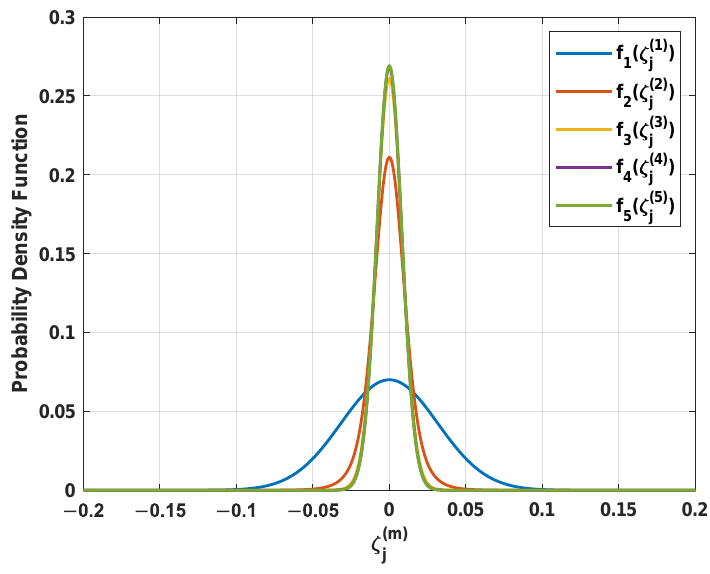
( m ) in each iteration. j